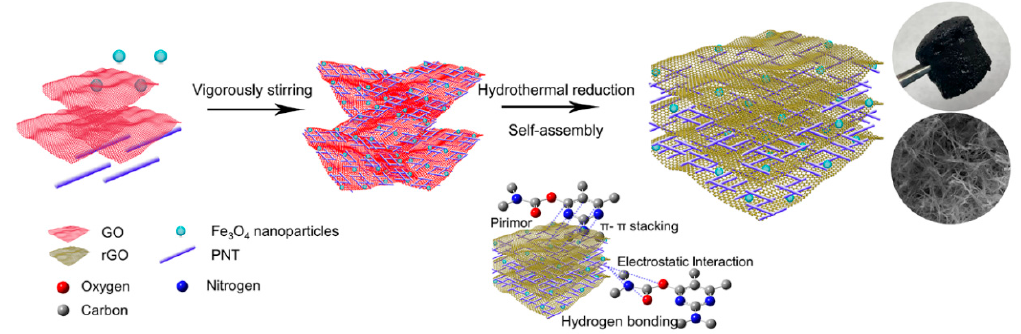
Figure 1. The schematic illustration of the synthetic process of the 3D-rGOPFH.